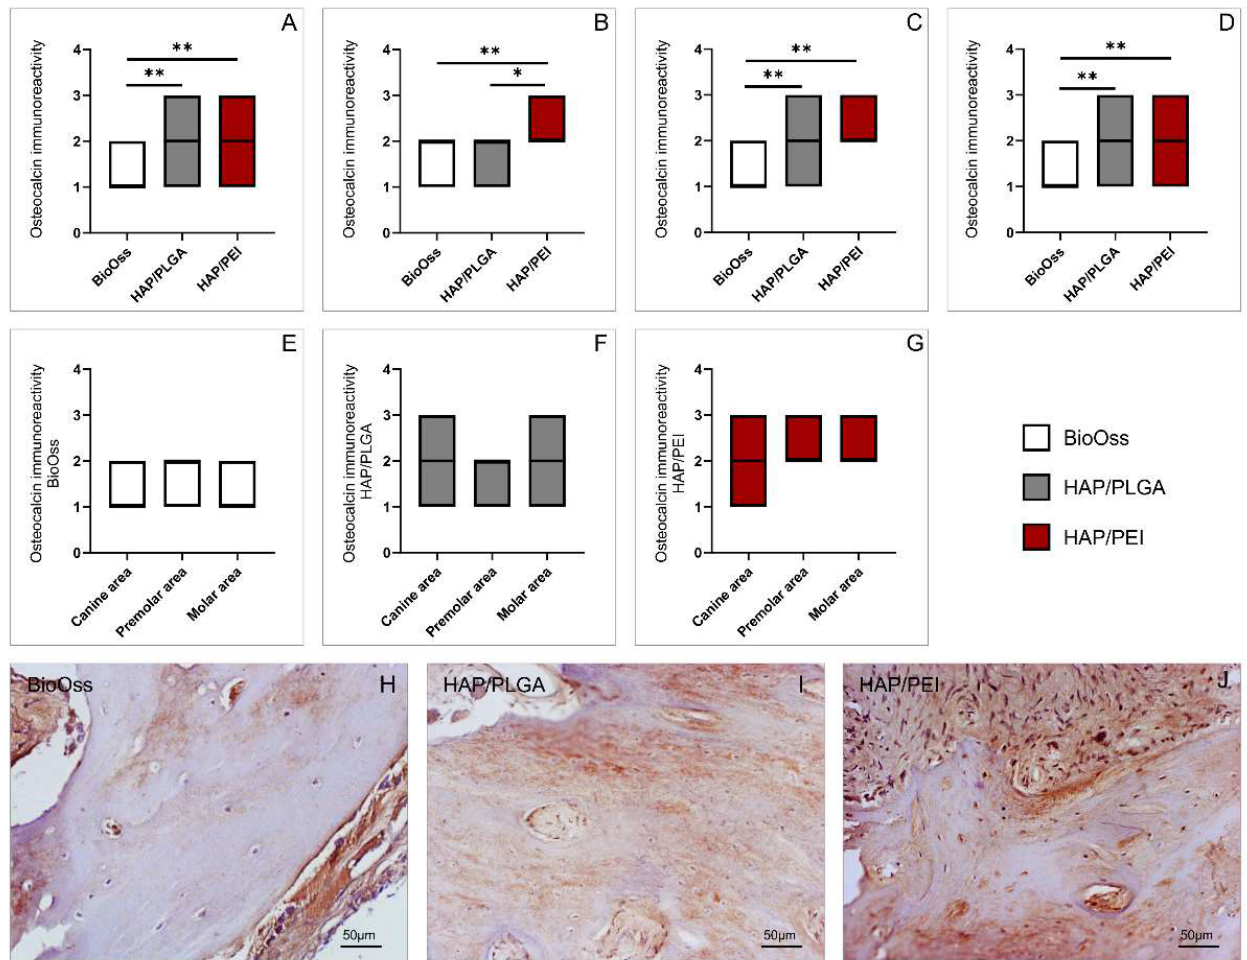
Figure 3. Immunoreactivity to osteocalcin: ( A ) canine area, ( B ) premolar area, ( C ) molar area, ( D ) whole mandibula, ( E ) BioOss graft, ( F ) HAP/PLGA graft, ( G ) HAP/PEI graft; representative images of H&E staining on paraffin-embedded sections (original magnification × 20): ( H ) BioOss graft, ( I ) HAP/PLGA graft, ( J ) HAP/PEI graft. Boxes represents interquartile ranges. Thick horizontal line within a box represents a median. The values are mean ± standard error of the mean (SEM), * denotes a significant difference p < 0.05, ** denotes a significant difference p < 0.01.